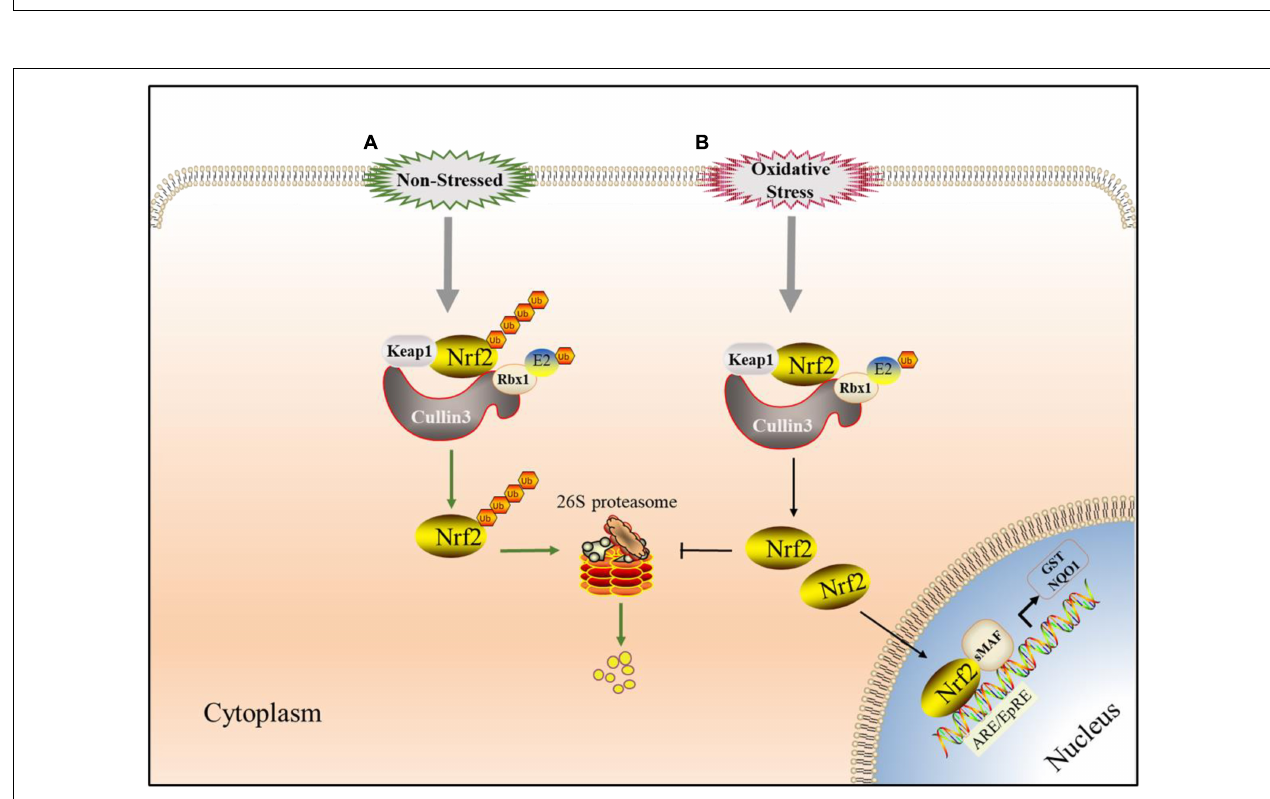
FIGURE 3 | PINK1/Parkin pathway mediates ubiquitination of mitochondria. (A) Under basal condition, PINK1 passes through the outer mitochondrial membrane (OMM) to the inner membrane (IMM), and its transmembrane segment is hydrolyzed by presenilins-associated rhomboid-like protein (PARL) protein. The treated PINK1 is released into the cell matrix and mediated proteasome degradation by E3 ubiquitin ligases (UBR1, UBR2, and UBR4). (B) When mitochondrial disorder, PINK1 cannot be transported across membranes, so that it cannot be destroyed by PARL. Instead, PINK1 stably binds to the OMM and accumulates on it. Therefore, PINK1 can directly phosphorylate ubiquitin or Parkin. Parkin is recruited by phosphorylated ubiquitin to various mitochondrial substrate proteins(S) in which mitochondrion is ubiquitinated.